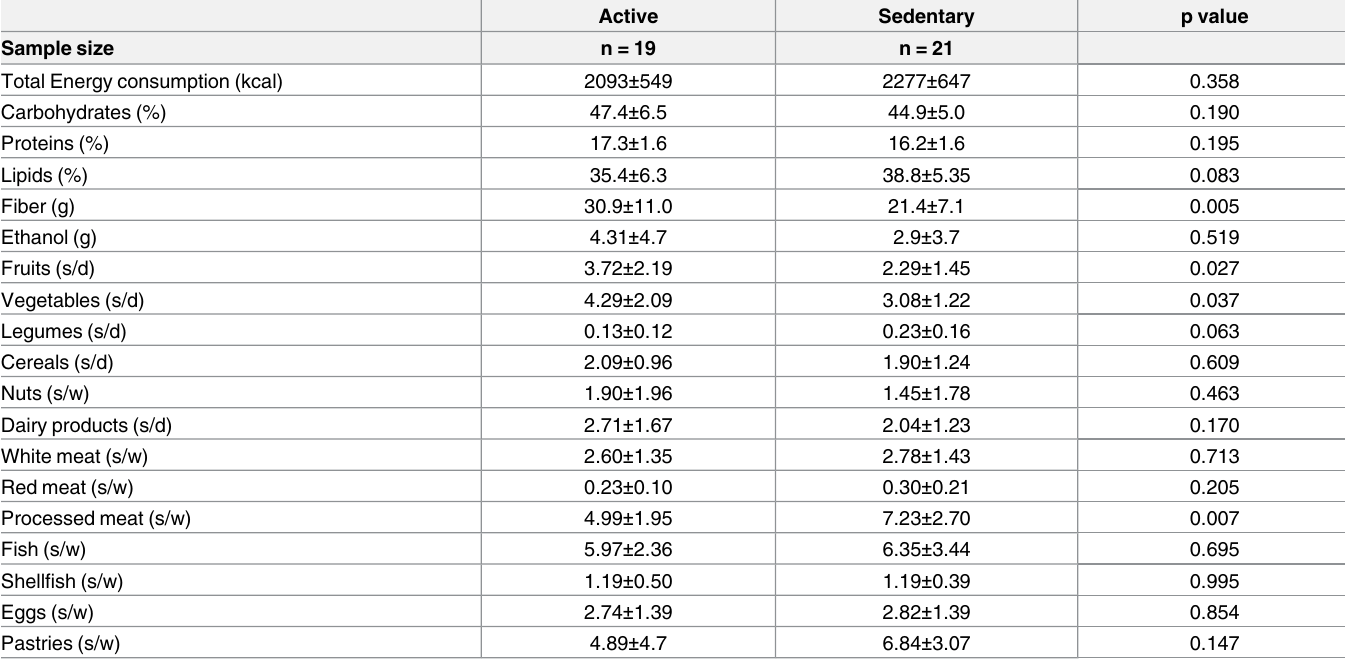
Table 2. Consumption of macronutrients, fiber, ethanol and main food groups.